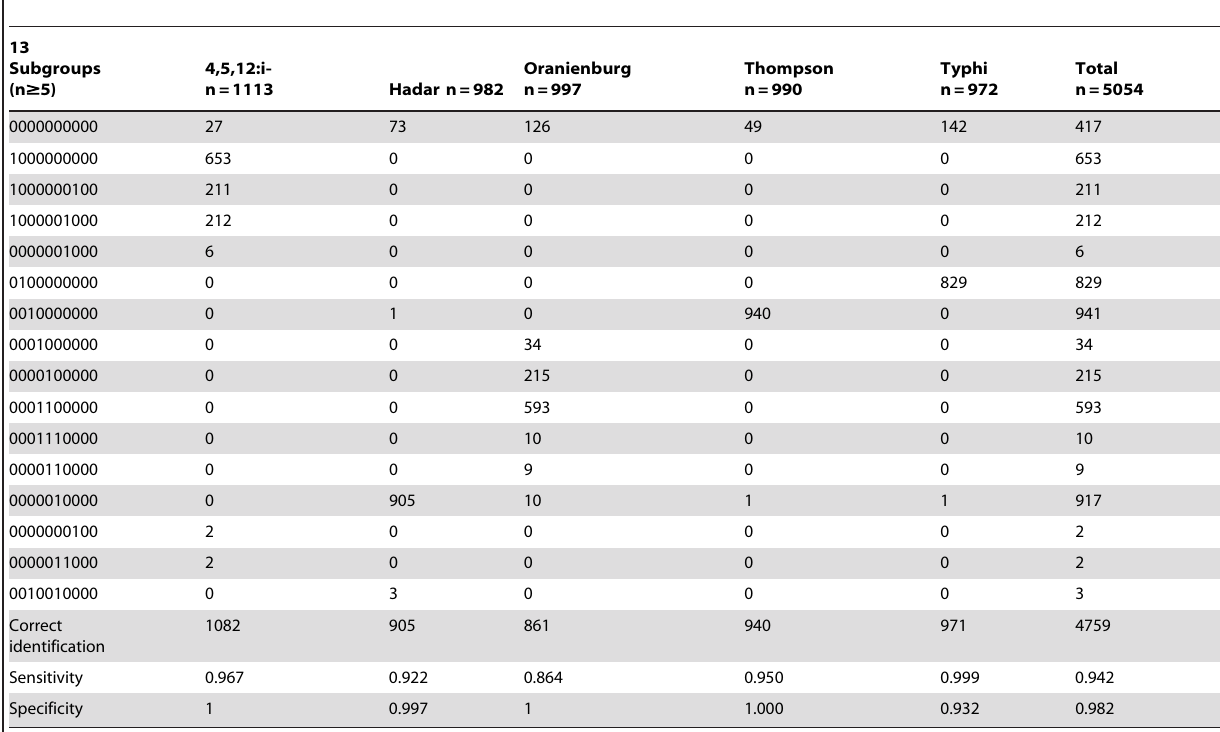
Table 4. Frequency distributions of classification patterns identified by the SVM composite model (m 1 –m 10 ) for the Salmonella PFGE training dataset consisting of five